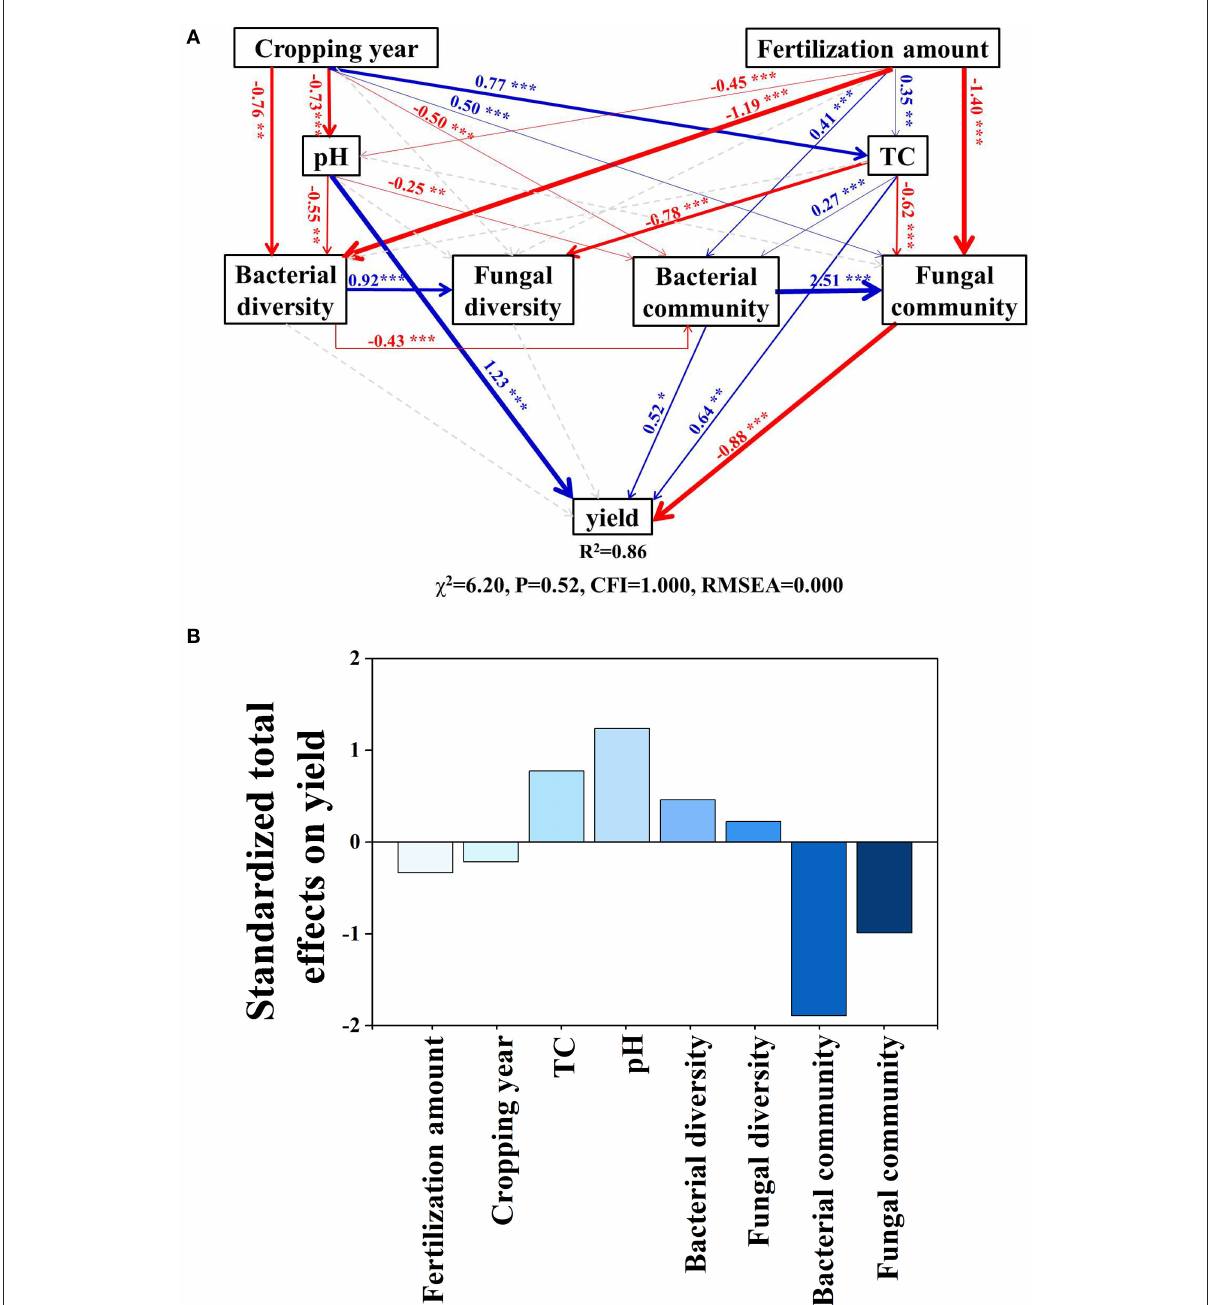
FIGURE6 Effects of multiple factors on crop yield. (A) Structural equation modeling based on the effects of cropping durations, fertilization, soil properties (pH and TC), bacterial diversity and community composition, fungal diversity and community composition on crop yield. (B) Standardized total effects. Red arrows indicate significant negative and blue positive relationships. Dashed arrows represent non-significant relationships. Arrow width indicates the strength of the relationships. Numbers at arrows are standardized path coefficients. R 2 denotes the proportion of variance explained by the model. * p < 0.05; ** p < 0.01; *** p < 0.001. TC, total